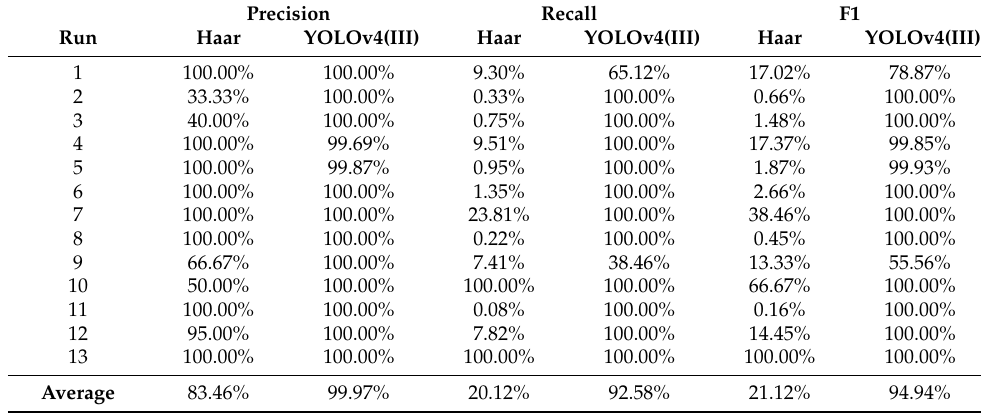
Table 5. Precision, recall, and F1 for positive